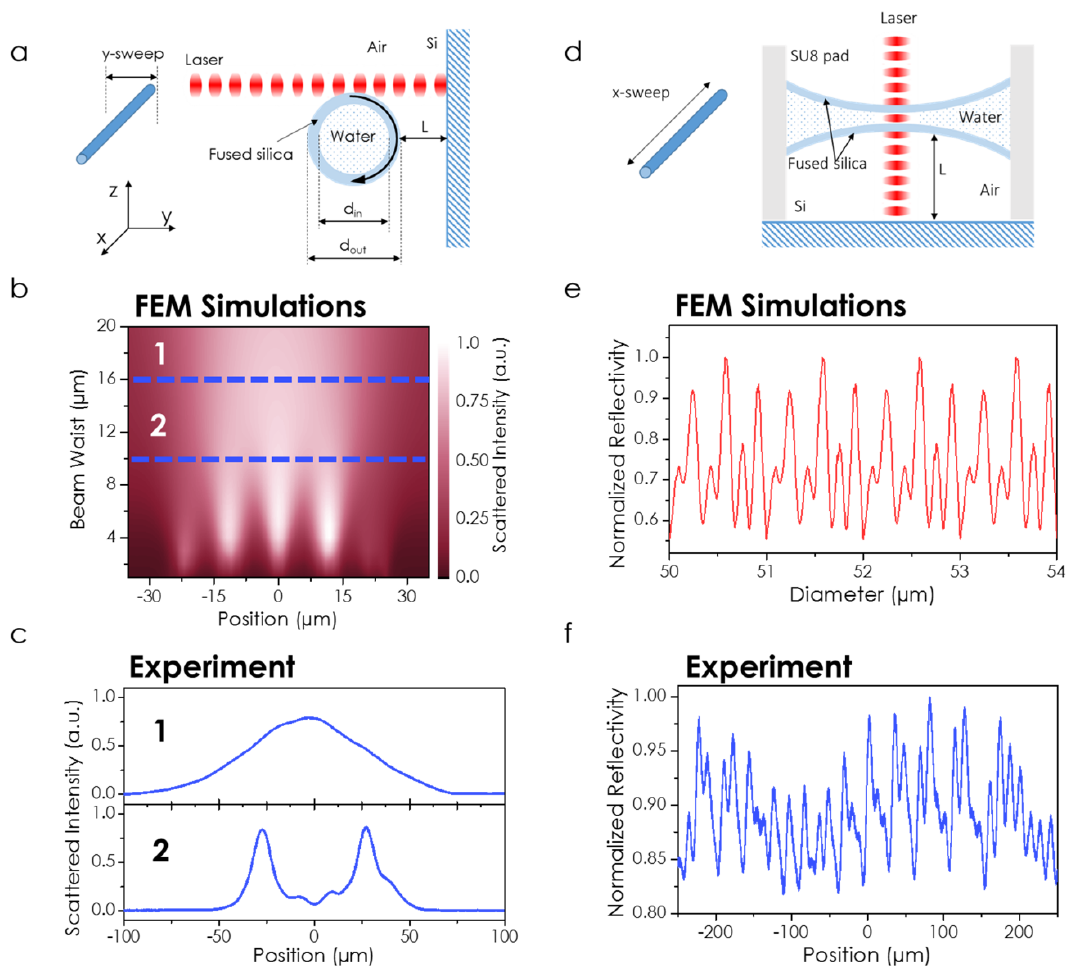
Figure 2. ( a ) Schematics of transversal sweep (y-sweep). ( b ) Simulations by using Finite Element Method (FEM) of the scattered intensity while varying the beam waist for different relative positions of the capillary and the laser beam (y-sweep). ( c ) Experimental demonstration of the scattered intensity for y-sweeps at different beam waists. ( d ) Schematics of longitudinal sweep (x-sweep). ( e ) FEM simulations of the scattered intensity as a function of the outer diameter of the capillary. ( f ) Experimental demonstration of the scattered light modulations for an x-sweep.